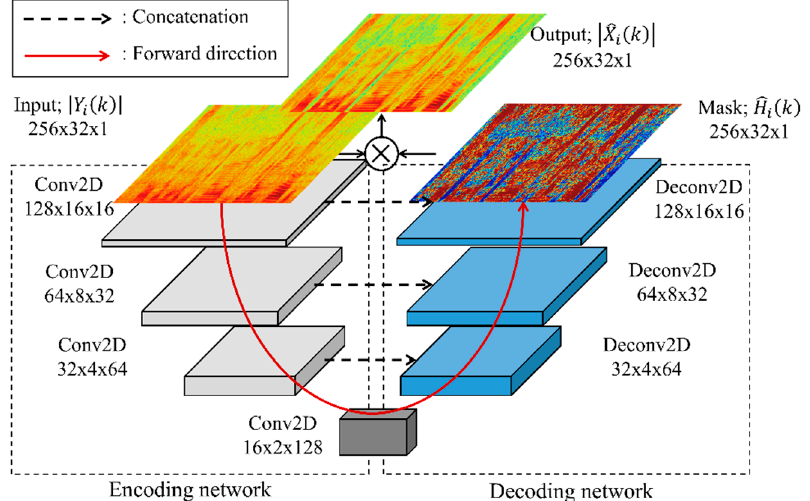
Figure 1. Network architecture of the U-Net-based single-channel speech enhancement.